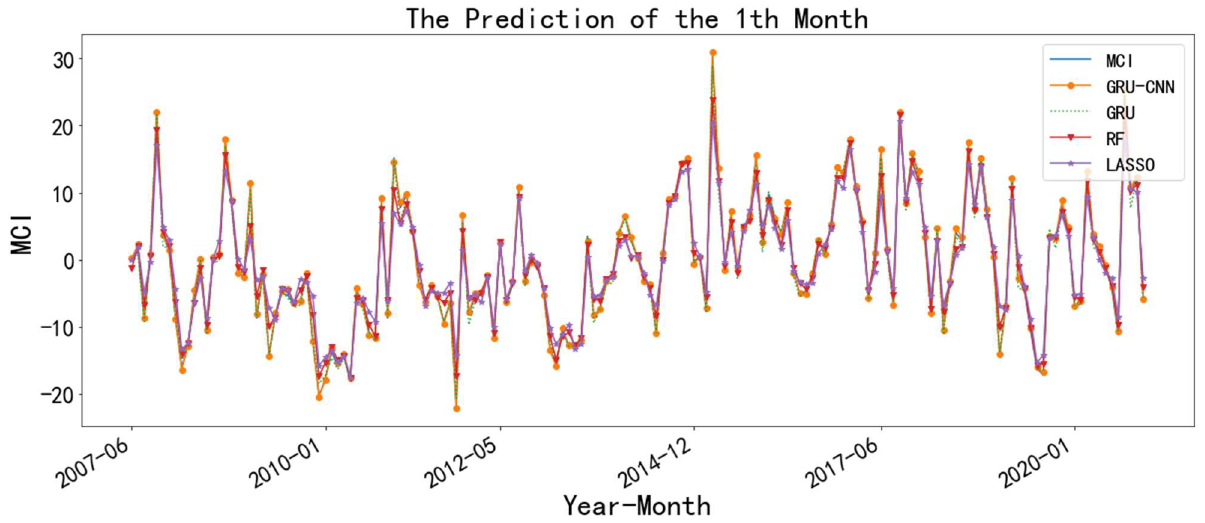
Figure 7. The prediction of the MCI at the Lincang station with 1-month leading.